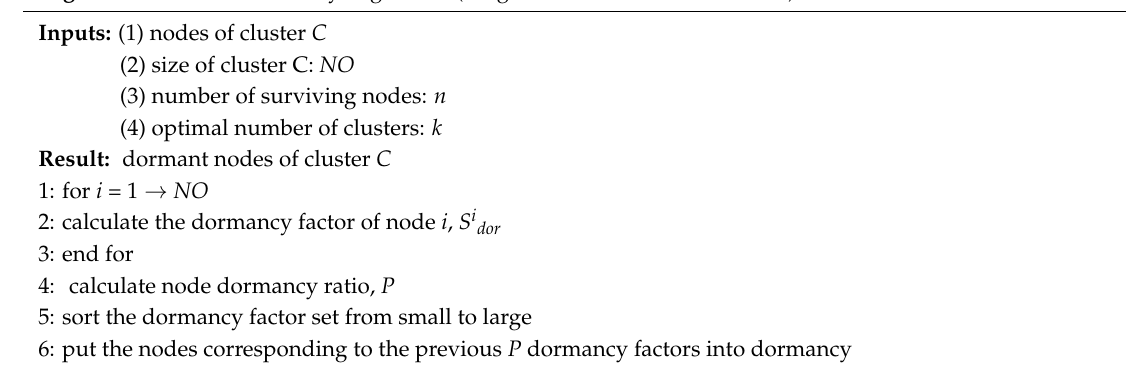
Algorithm 4. Node Dormancy Algorithm (Large Cluster of Unstable